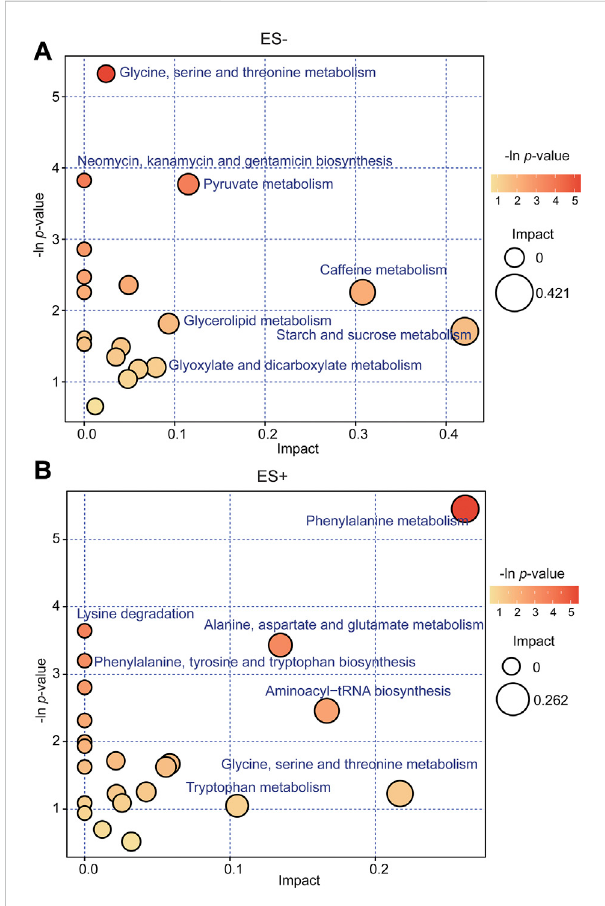
FIGURE 4 Kyoto Encyclopedia of Genes and Genomes (KEGG) pathway analysis of the differentially expressed compounds for group HTN-S vs. HTN-NS. (A, B) , Bubble plots in ES − and ES + showing the enriched metabolic pathways of varied metabolic compounds between groups, respectively. The color and Y -axis of dots are based on the -lnP-value, and the enrichment degree is more signi fi cant when the color is darker. The size and X -axis of dots represent the impact factor of the pathway in the